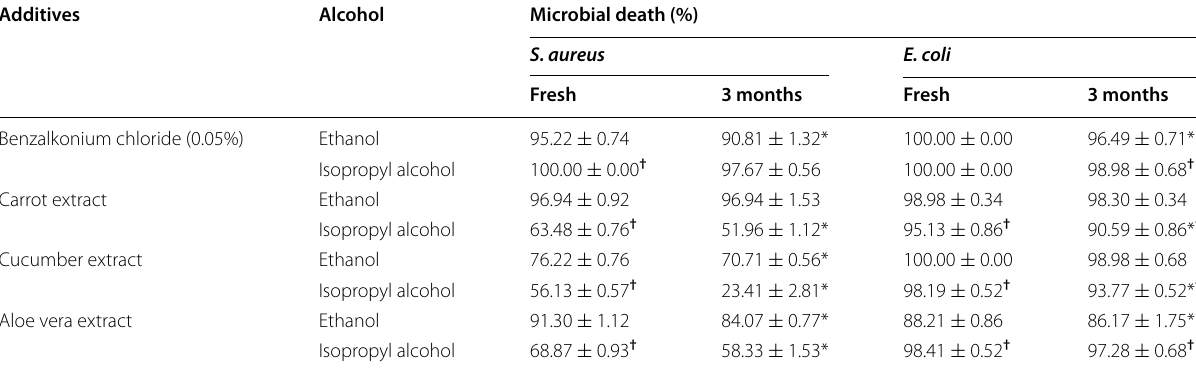
Values represent means SD. Values with * indicate a significant difference ( P < 0.05) from fresh sample for the same alcohol/additive/organism. Values with † indicate ± significant difference ( P < 0.05) from ethanol for the same additive/organism/test time.